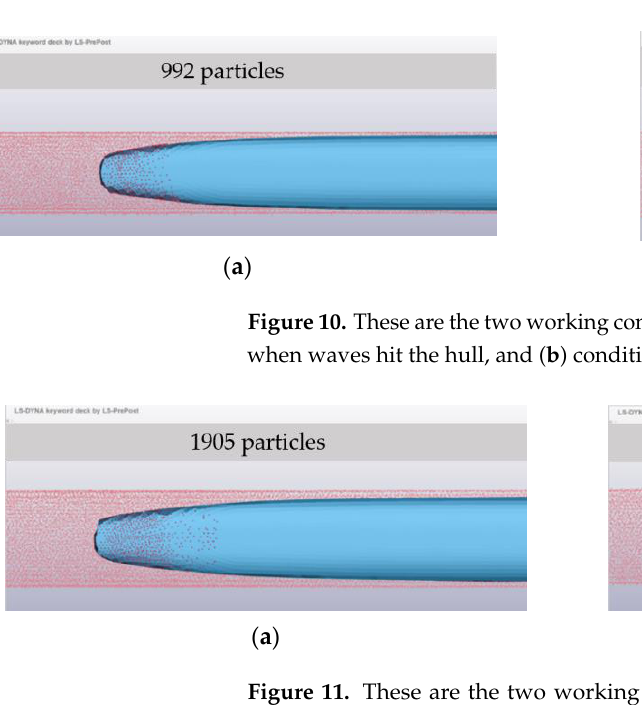
Figure 10. These are the two working conditions of Scenario 2: ( a ) conditions in the fifth-level sea state when waves hit the hull, and ( b ) conditions when the fifth- level sea state’s sea spray particles settle.